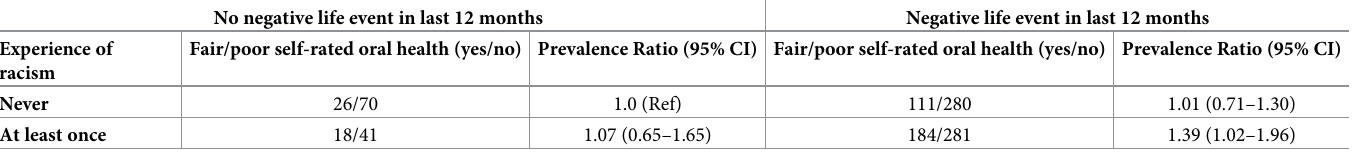
Relative Excess Risk due to Interaction: 0.31 (95% CI: 0.01–0.66) Prevalence ratios adjusted for: age, sex, residential location and difficulty paying a $100 dental